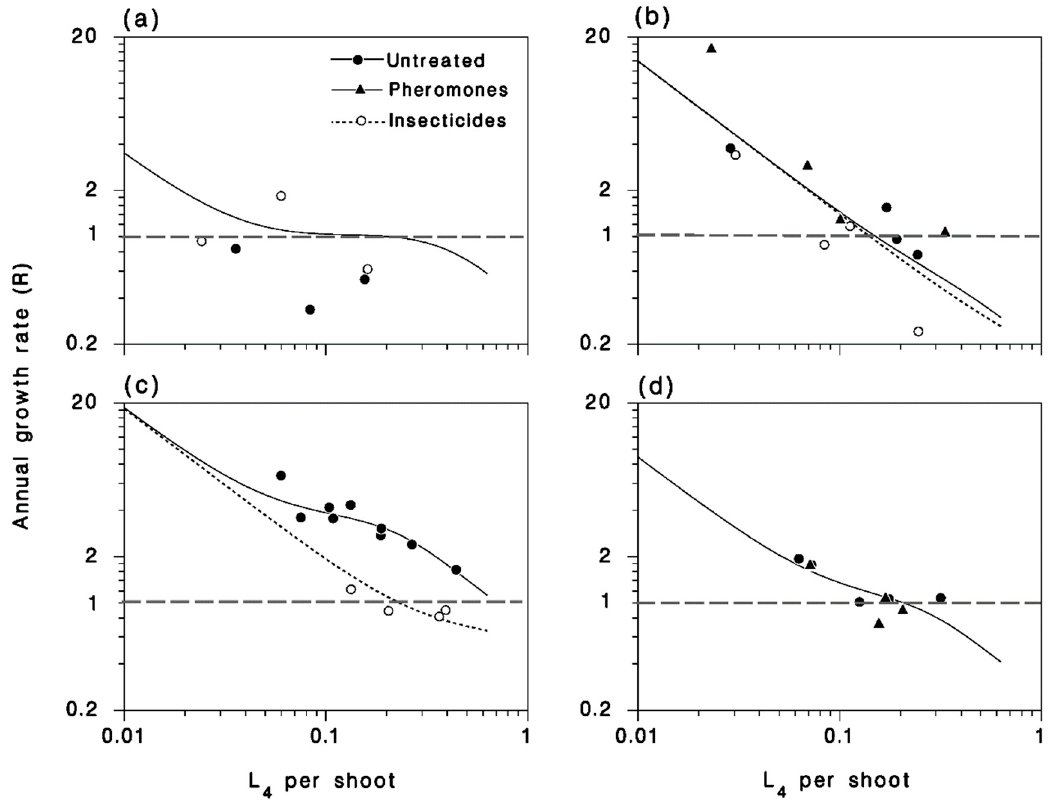
Figure 9. Relationships between larval population density (at the L 4 ) and annual population growth rate ( a ) 2012–2013; ( b ) 2013–2014; ( c ) 2014–2015 in the Lower St-Lawrence; ( d ) 2014–2015 in SOPFIM sites. Symbols: Observed. Lines: Expected from Equations (1) and (5). Horizontal dashed lines: Replacement level where R = 1.